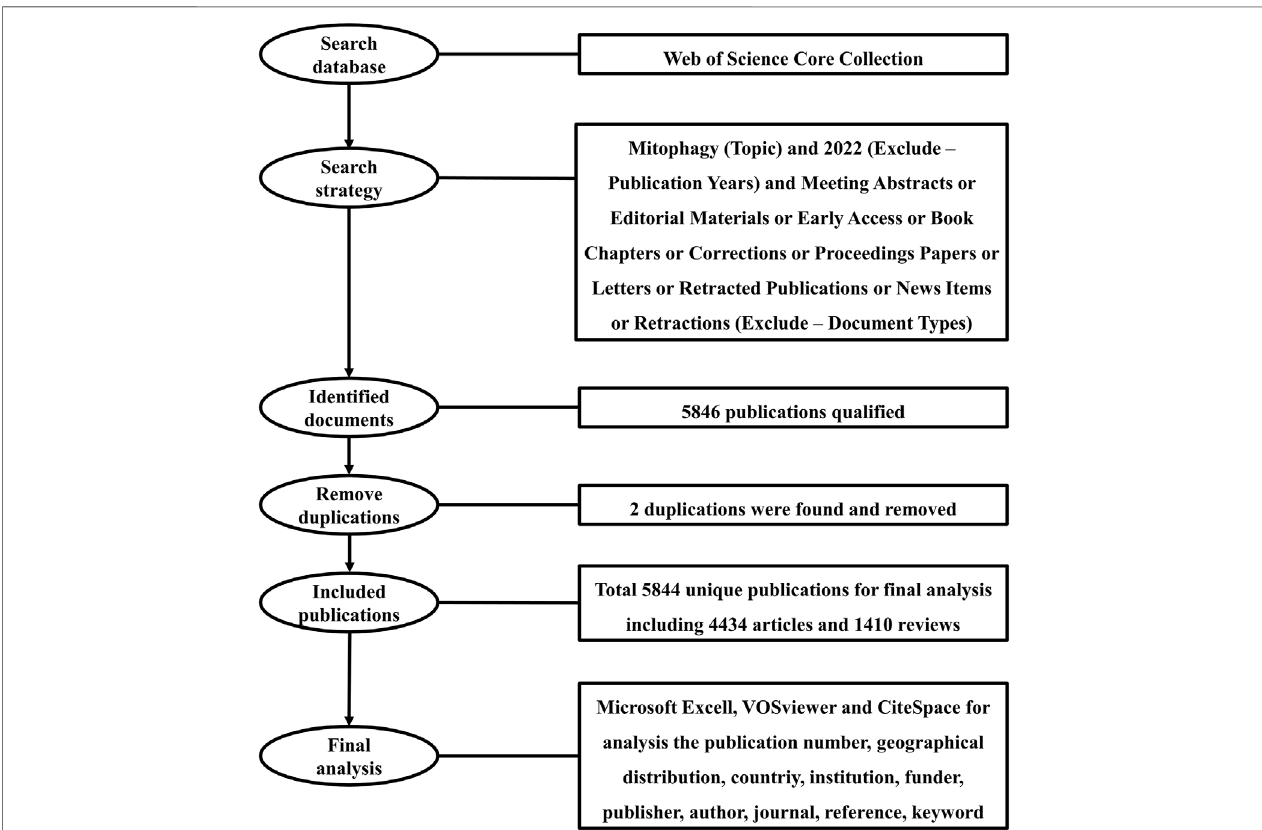
FIGURE 1 | Flowchart of the methodology and design of this